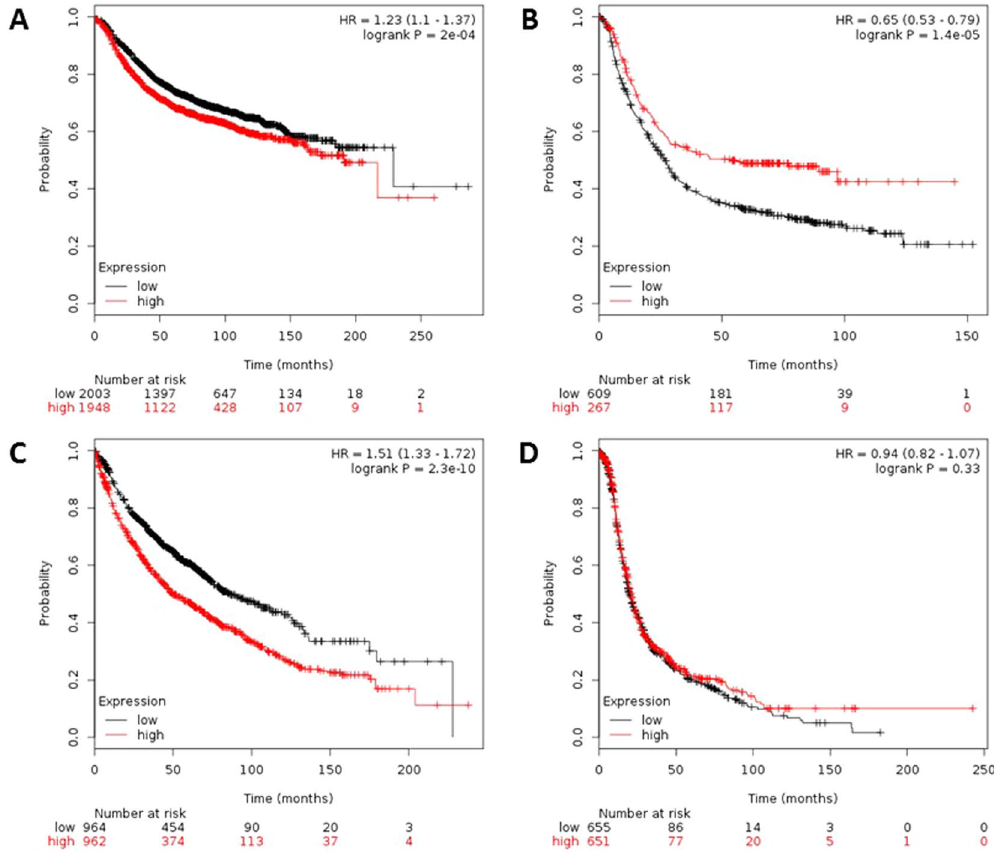
Figure 8. Microarray gene expression data based association of the deregulation of IL8 gene with survival of patients with different cancer